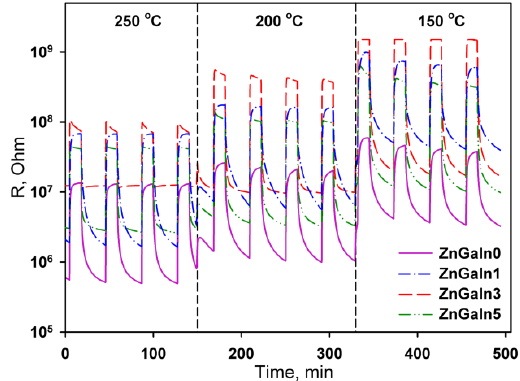
Figure 3. The resistance response of ZnO(Ga, In) samples to 0.7 ppm NO 2 at operating temperature 250–150 °C.